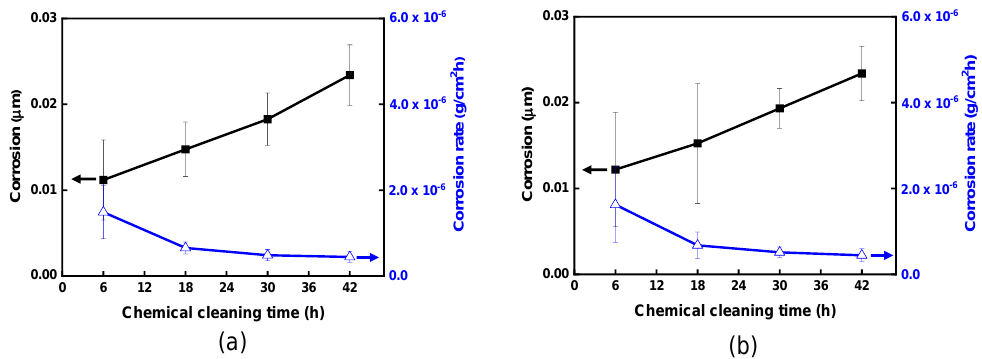
Figure 13. Corrosion of the STS 316L coupons under ( a ) the stagnant condition and ( b ) the flowing condition.